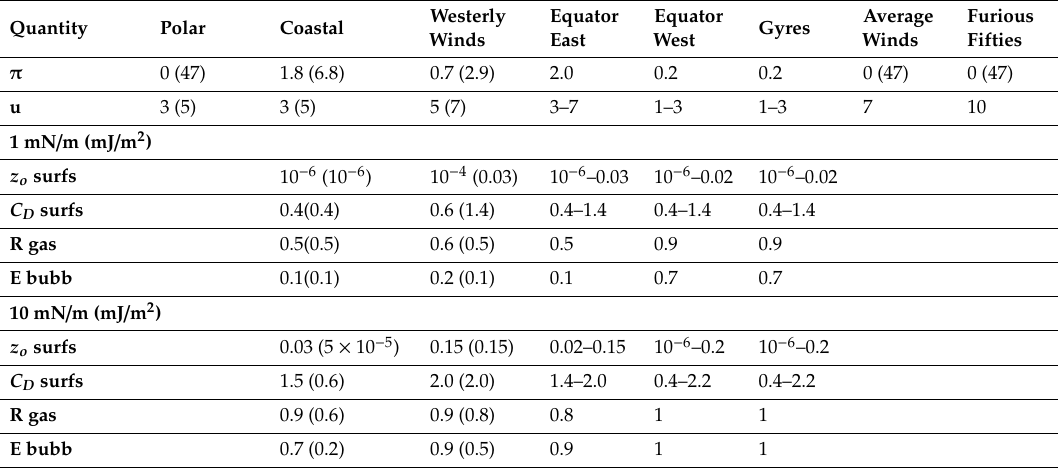
Table 4. Repeat of the previous table but with the primary π threshold set first at one (top) and then 10 (lower half) in the standard units. Blank columns mean that despite altering the shape of various profiles, there was little change. Dimensions (units) as before.